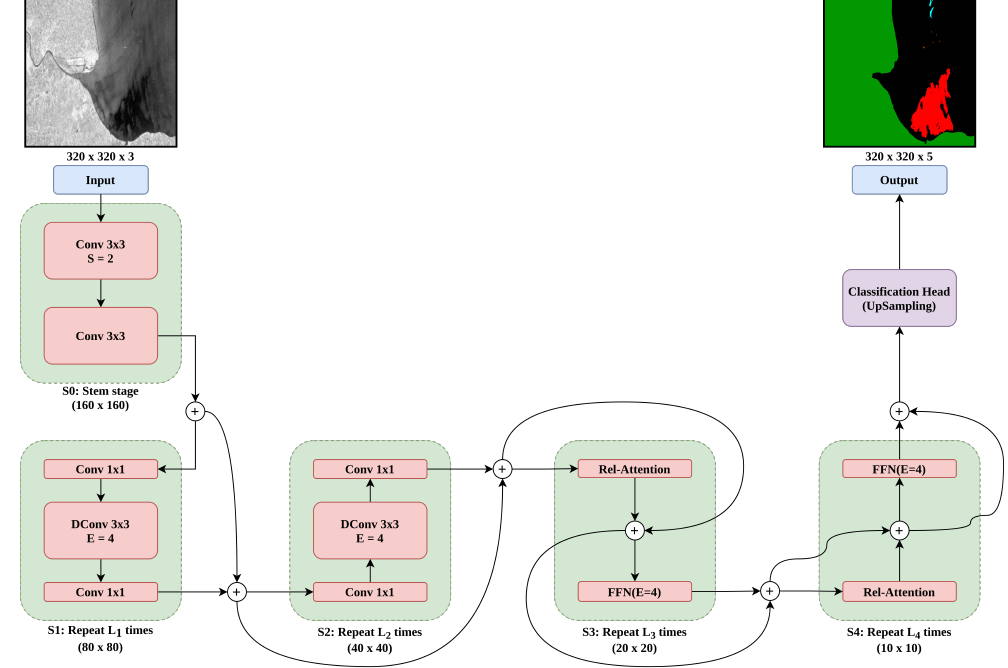
Figure 5. An overview of the CoAtNet architecture used for semantic segmentation of SAR images for oil spill classification. It has five stages, viz., S0, S1, S2, S3, and S4. Each stage reduces the dimensions of the input image by a factor of 1/2. For our classification problem, the input is a 320 × 320 × 3 SAR image and output is a 320 × 320 × 5 semantic segmentation mask with five desired